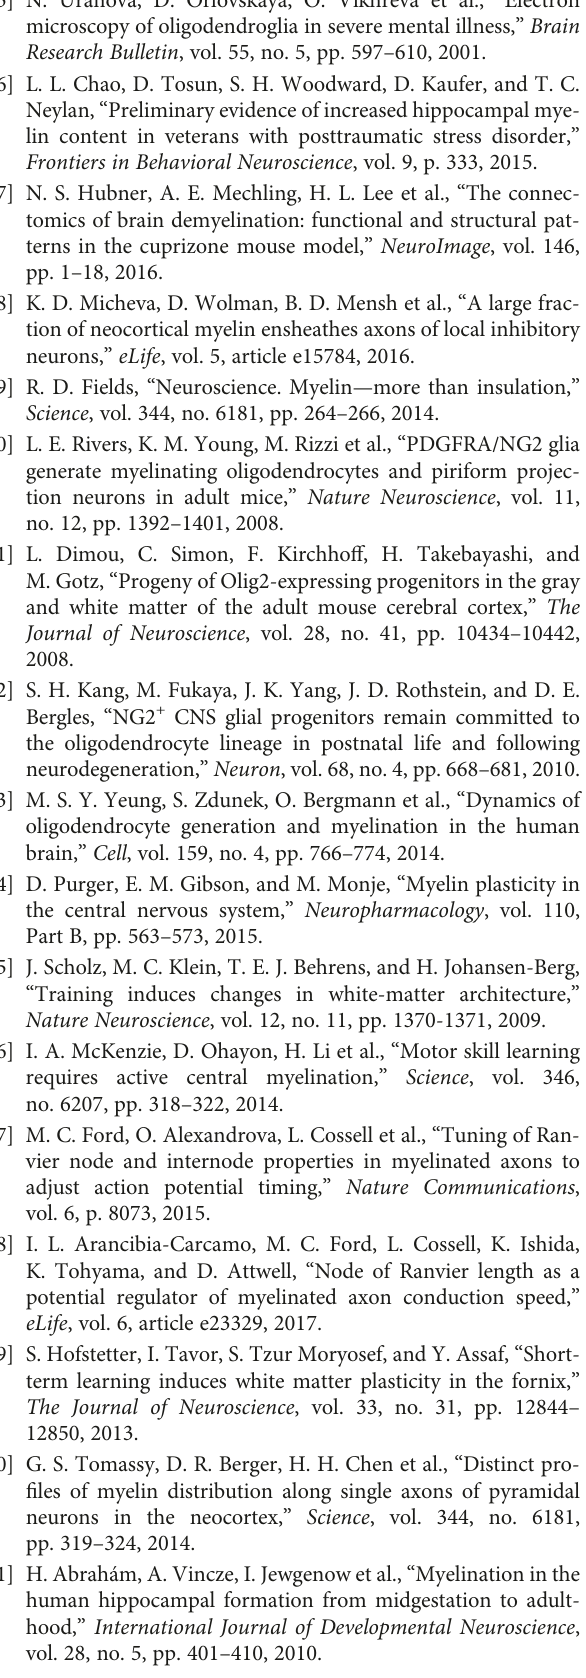
e ff ects following frontal lobe damage: fi ndings from tests of paired-associate learning, ” Journal of Cognitive Neuroscience